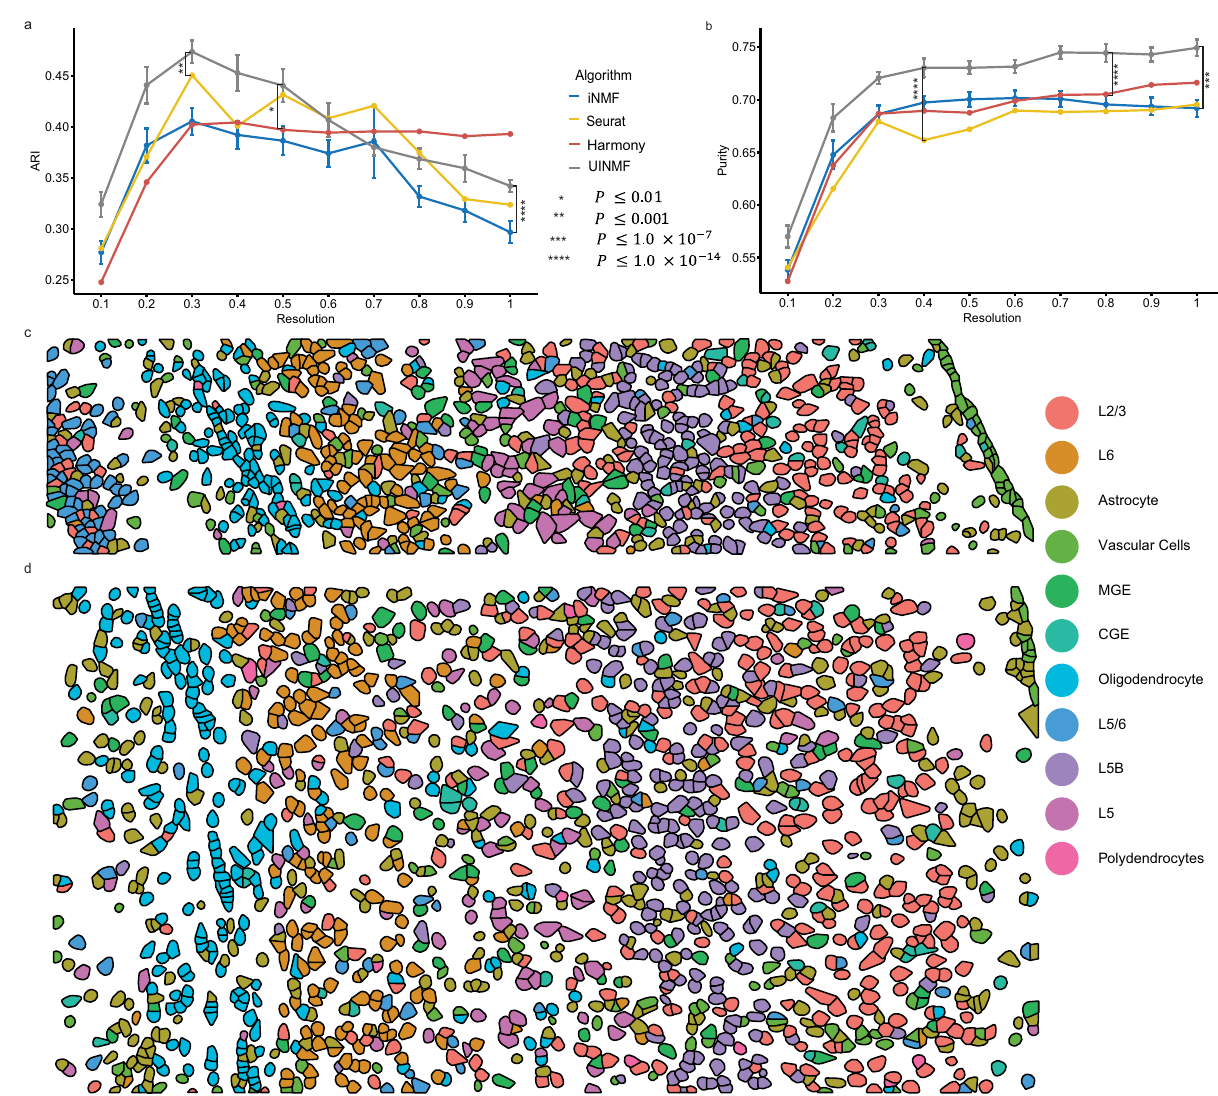
Fig. 7 Incorporating unshared chromatin and gene features improves integration of spatial transcriptomic and multimodal data. We compared UINMF results with those from iNMF ( P = 5.934 × 10 − 15 , P = 1.046 × 10 − 11 )), Harmony ( P = 0.002927, P = 2.2 × 10 − 16 ), and Seurat v3 ( P = 0.0004184, P = 2.2 × 10 − 16 ) using ARI ( a ) and purity ( b ) metrics. Comparisons were evaluated using a paired, one-sided Wilcoxon test ( n = 200 values for each test, with each sample having 10 values across 10 resolutions). For nondeterministic algorithms, data are presented as mean values + / − SEM. We also con fi rmed that the spatial arrangement of predicted cell types in both STARmap replicate one ( c ) and replicate two ( d ) matches the known organization of the